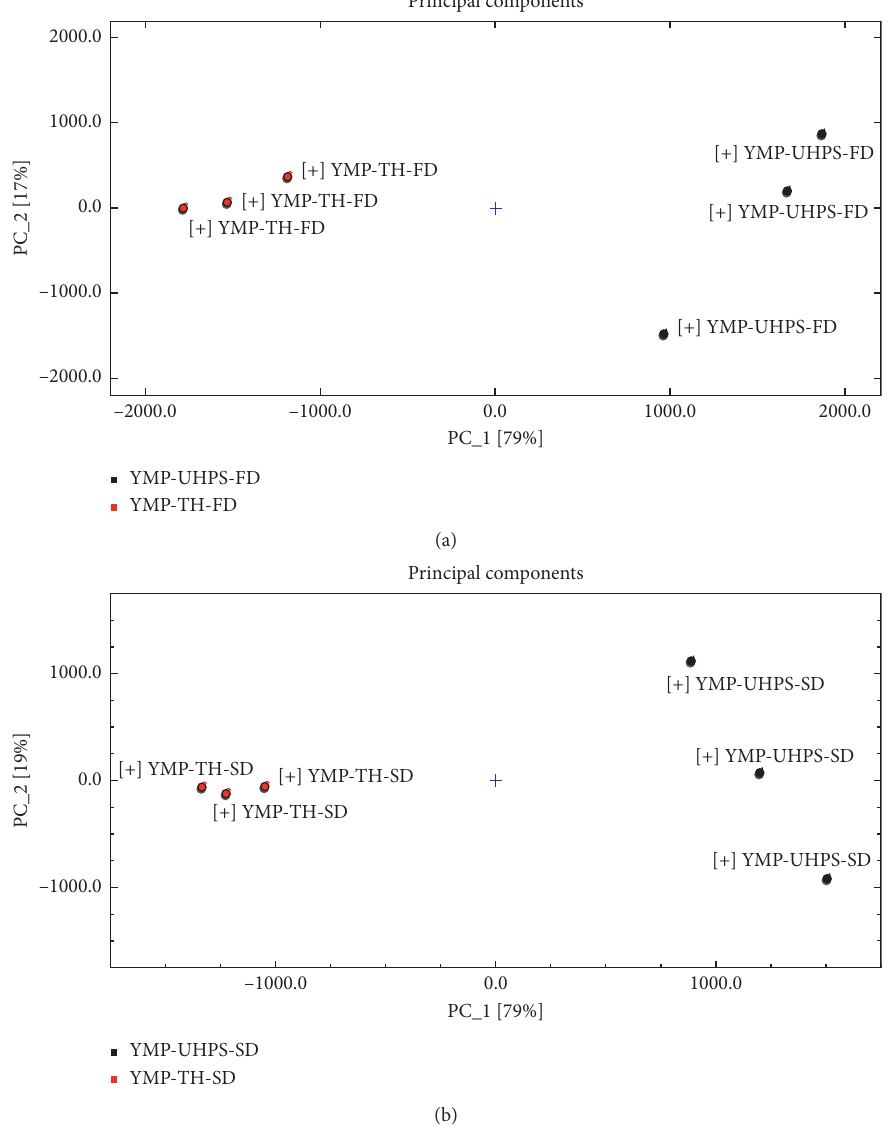
Figure 4: PCA of YMP with different sterilization methods.